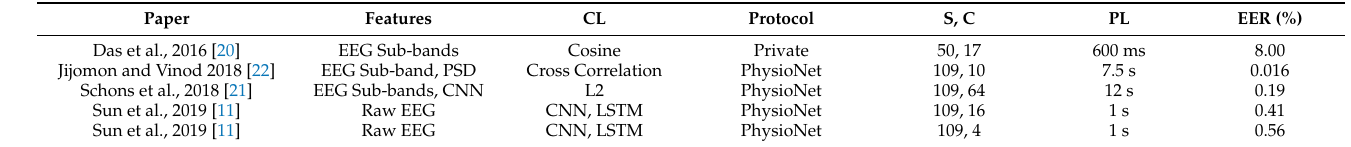
Table 2. EEG-based Authentication. Notations: CL—Classifier, S—Subjects, C—EEG